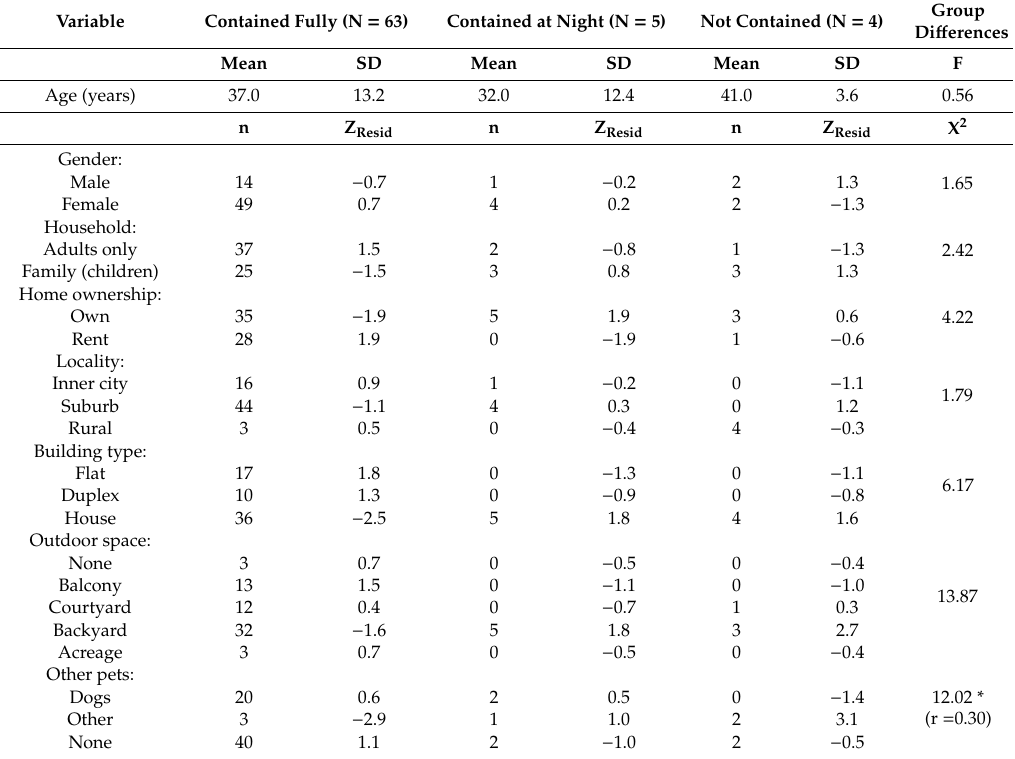
Table 3. Summary of demographic variables across the three containment profiles. Variable Contained Fully (N =